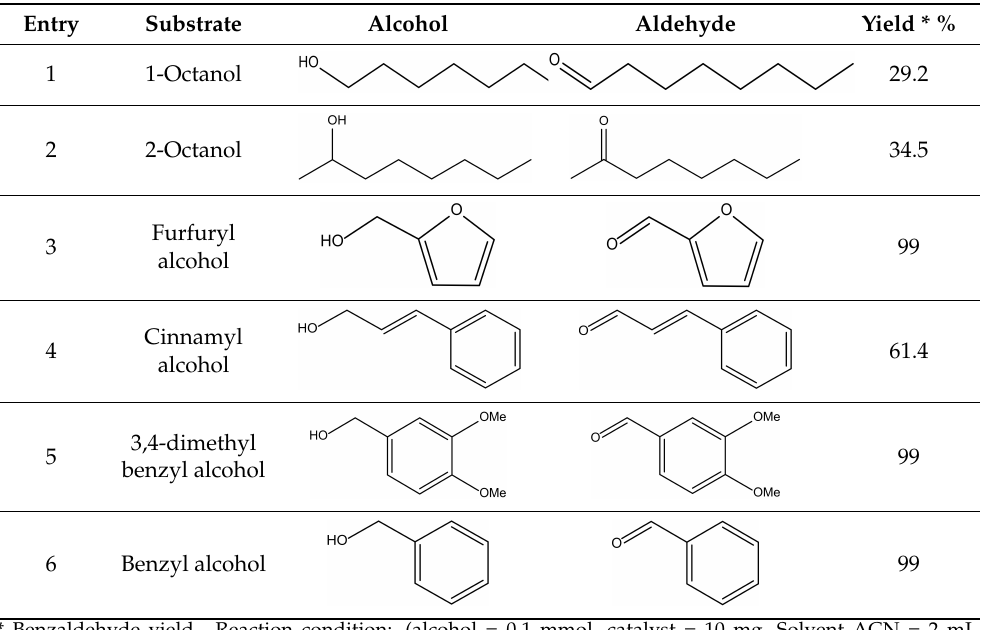
Table 4. Alcohol derivatives on the selective oxidation of benzyl